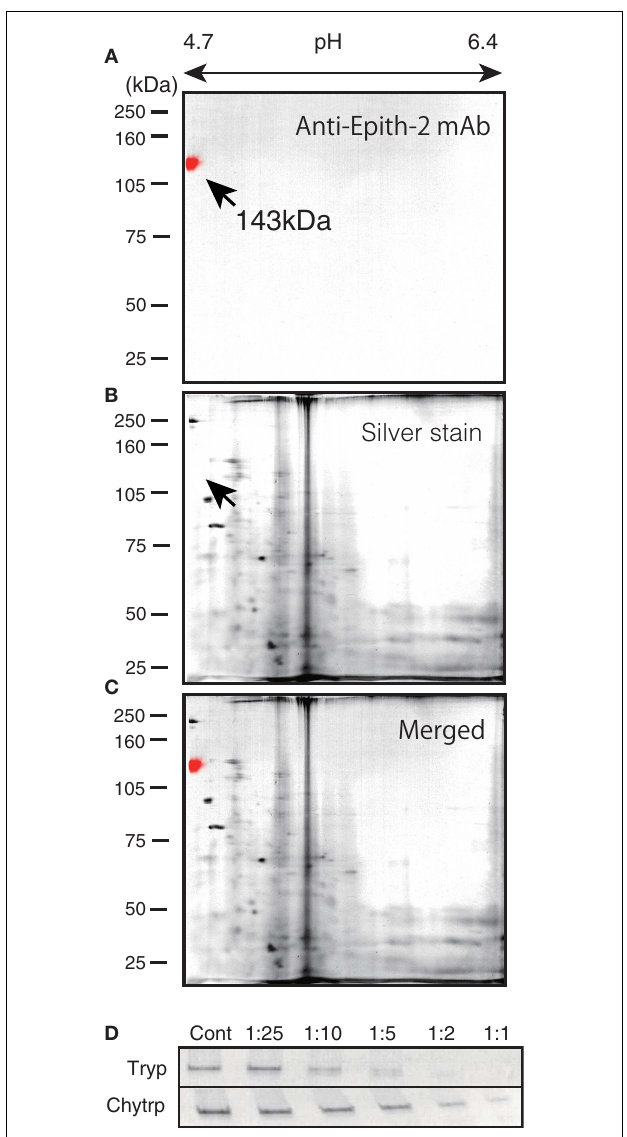
FIGURE 2 | Isoelectric points and molecular mass in Daltons separation (ISO-DALT) analysis of Epith-2 of H. pulcherrimus (A–C) and proteinase sensitivity of Epith-2 T. hardwicki (D) . (A) ISO-DALT 2D immunoblotting shows an immunopositive spot at the 143kDa and pH 4.7 (red) region.The spot is artificially colored. (B) ISO-DALT 2D pattern stained with silver. (C) Merged image between (A,B) . (D) Protease digestion of Epith-2 of swimming blastulae. Cont, control; the numbers, dilution ratios of protease,Tryp, trypsin digested. Chytrp, chymotrypsin